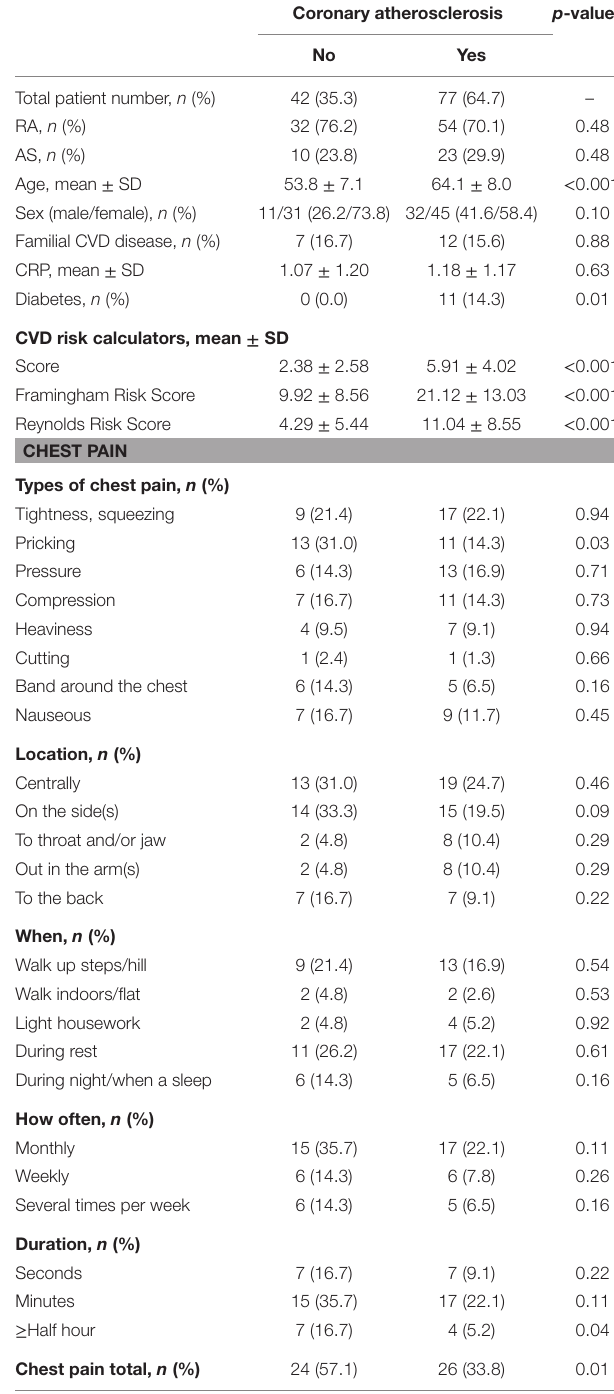
TaBle 1 | Baseline characteristics of patients examined by MDcT coronary